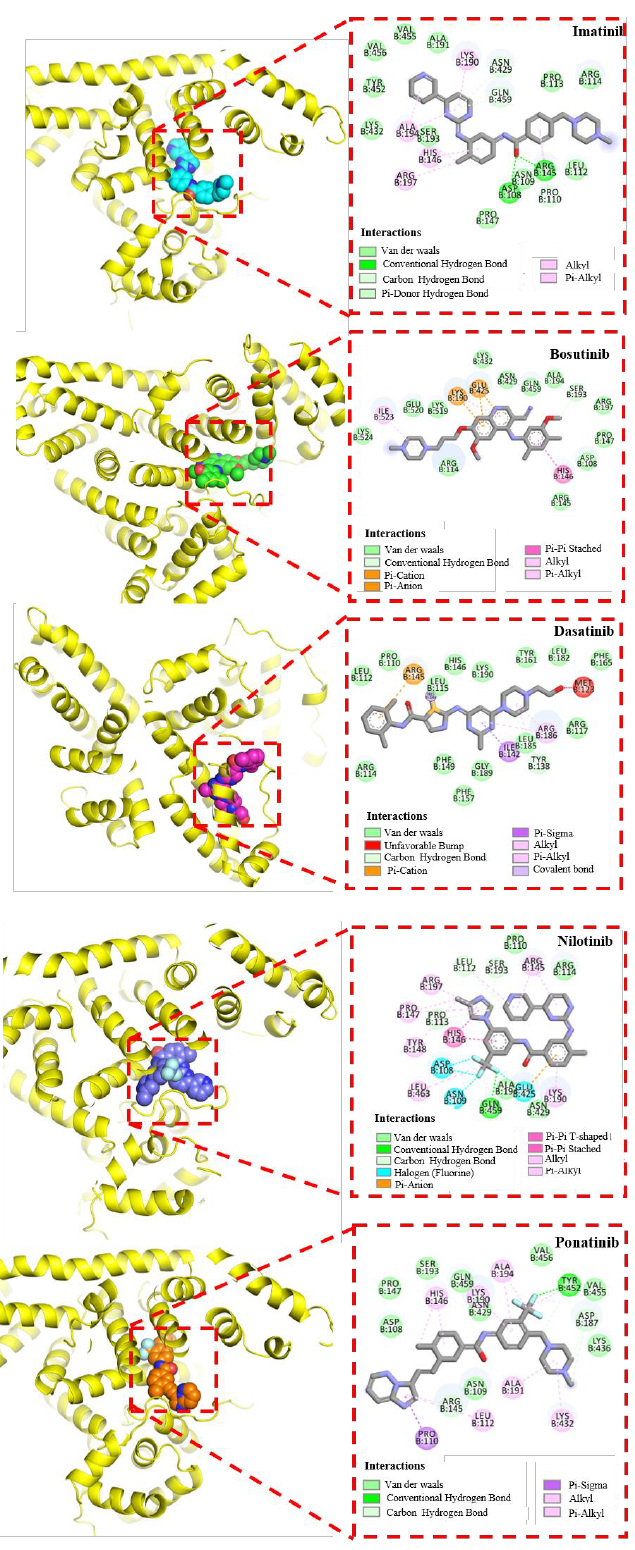
Figure 8. Predicted binding orientation of TKIs (rendered in spheres with lowest docking energy) in site I of HSA. The hydrogen bonding (green dotted lines) between the amino acid residues and TKIs is highlighted in the binding